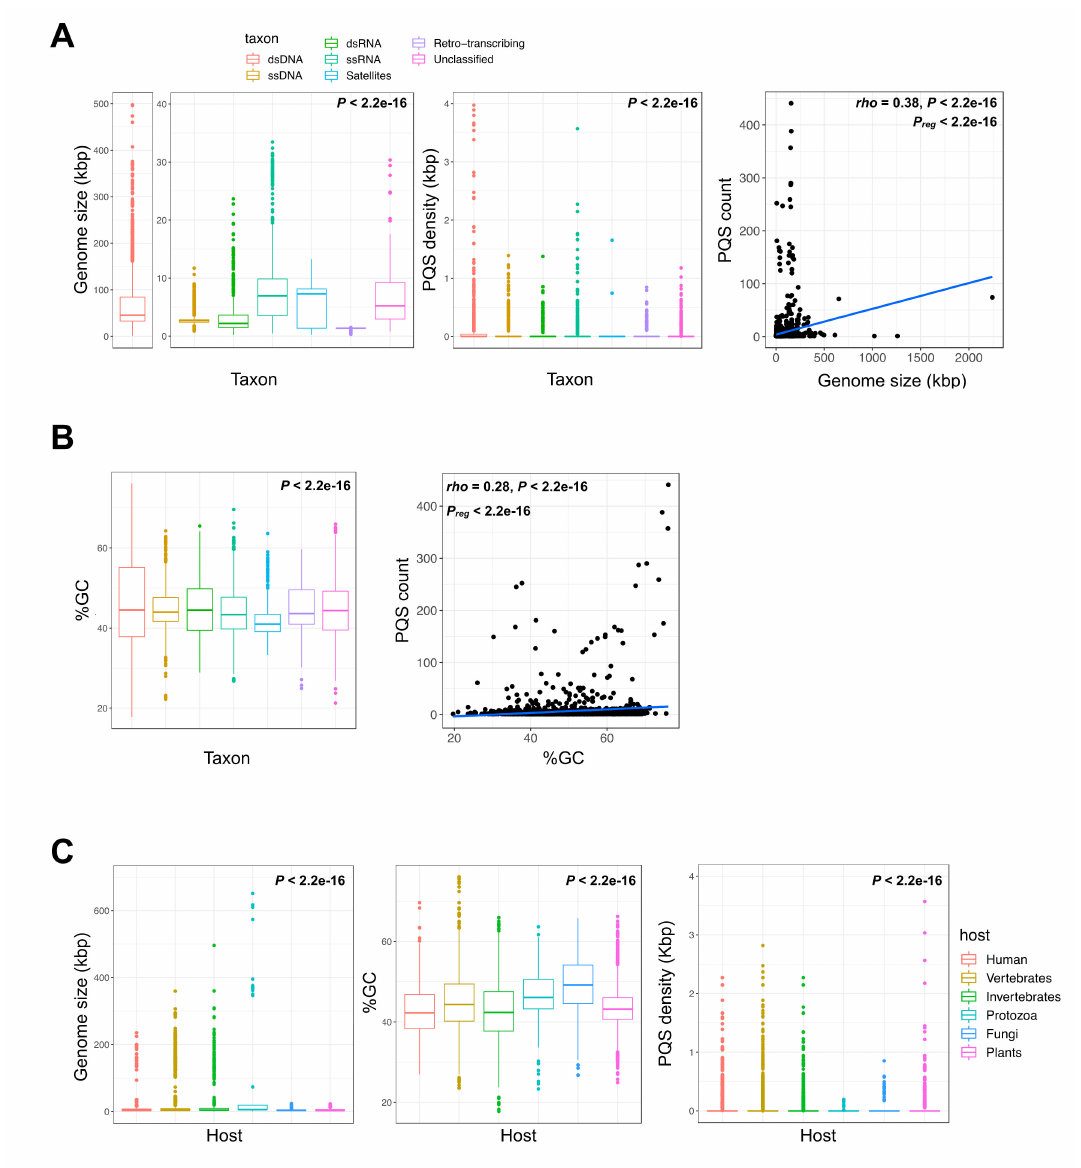
Figure 1. Genome metrics and quadruplex motif content of viral genomes. ( A ) From left to right, genome size (in kilo base pairs, kbp), putative quadruplex sequence (PQS) density (number of motifs found per kbp), and relationship between PQS content and genome size for di ff erent viral taxa. ( B ) GC content and relationship between PQS content and GC content for di ff erent viral taxa. ( C ) From left to right, genome size, GC content, and PQS density for di ff erent eukaryote host groups. For panels A through C, di ff erences in average size, GC, and density values were assessed using Kruskal–Wallis rank sum tests and pairwise Wilcoxon rank-sum tests. Spearman correlation coe ffi cients and their statistical significance are provided at the top of the scatterplots. Regression lines are shown in blue (P reg , linear regression